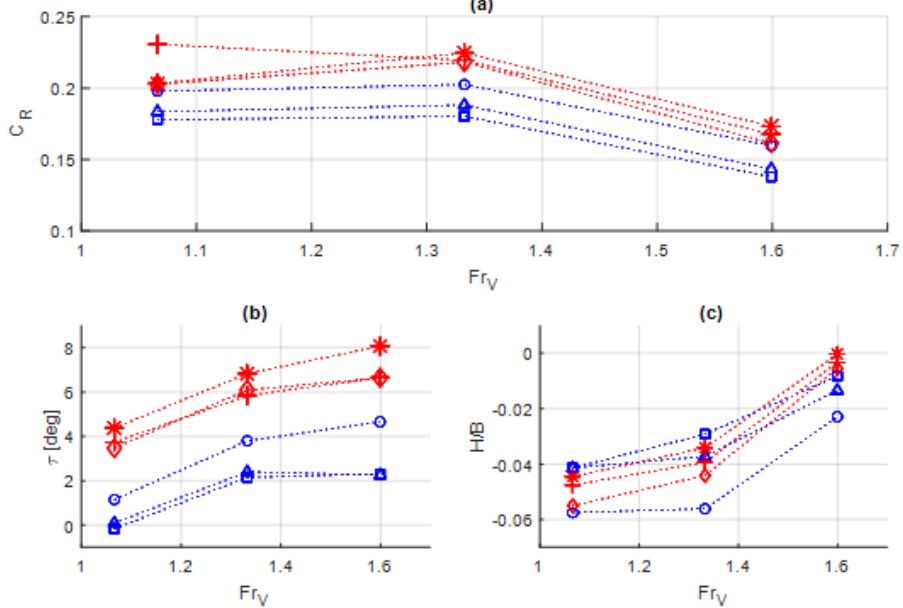
Figure 11. Comparison of hydrodynamic characteristics in the transitional regime of overloaded hulls ( C B = 1.276) with LCG = 45% (blue smaller symbols) and LCG = 40% (red larger symbols). ( a ) Drag coefficient, ( b ) trim angle, ( c ) normalized rise of the center of gravity. Circles and stars, constant-deadrise hull; squares and crosses, concave hull; triangles and diamonds, convex hull.